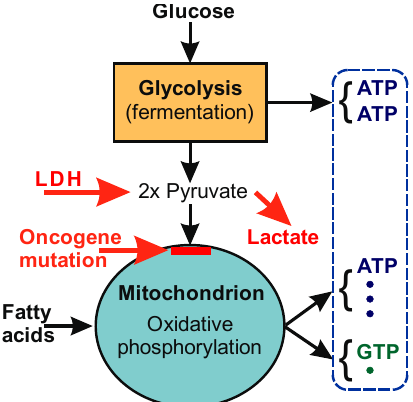
Figure 2. Energy transformation by glycolysis and oxidative phosphorylation in living cells. Cancer development can result from inhibition of pyruvate transfer to mitochondrial matrix. Parasitic energy consumption and transfer of pyruvate to lactate form a parallel pathway to mitochondrial dysfunction caused by deactivated PDH enzymes.